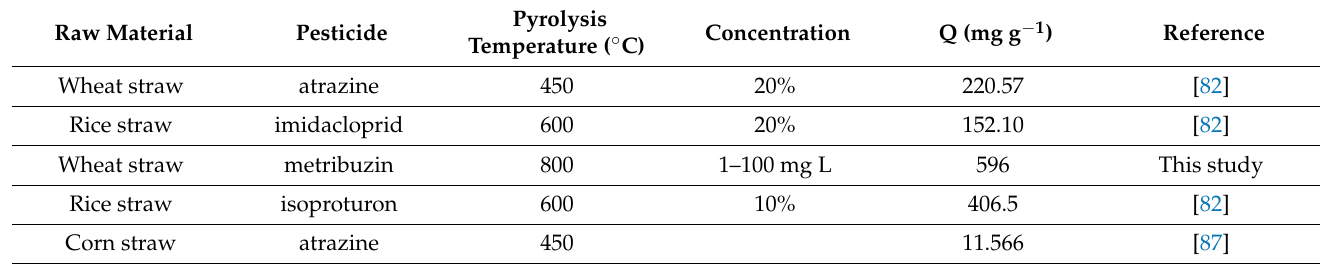
Table 4. Comparison of pesticide capacities on various